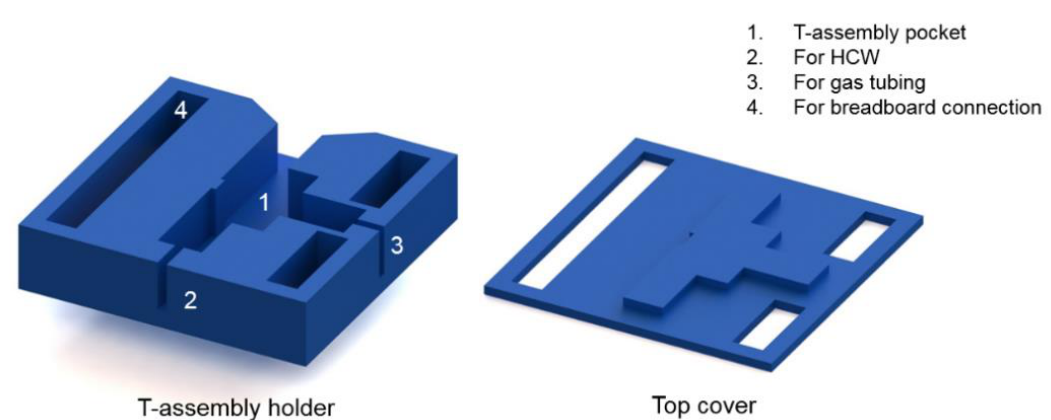
Figure 1. ( a ) Schematic of ultraviolet (UV) absorbance detector: Gas cell with gas and optics connectors. ( b ) Schematic for measuring the absorbance in volts. LabVIEW based data acquisition (DAQ) system was used to record the data.